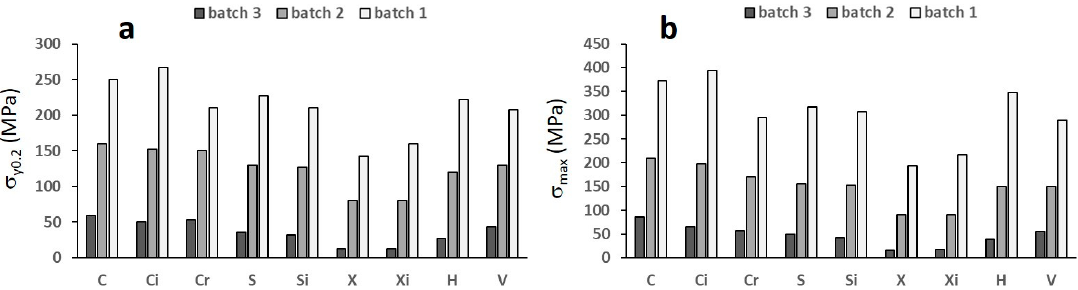
Figure 11. ( a ) The yield strength and ( b ) the maximum compressive strength. Mean scatter is 10 MPa and 12 MPa, respectively.